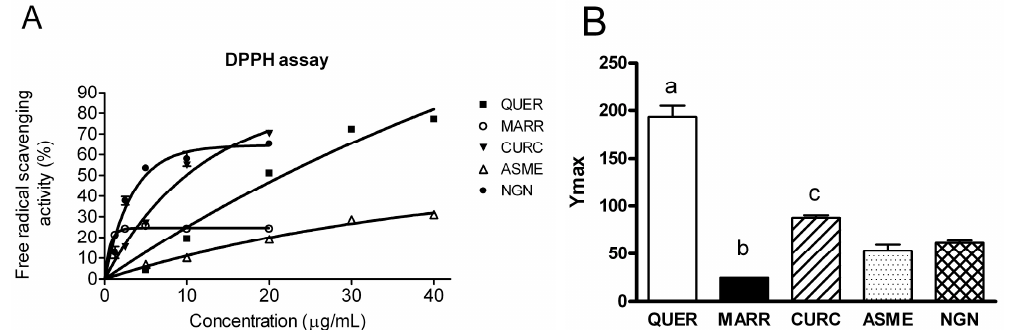
Figure 2. Antioxidant activity determination of quercetin (QUER), marrubiin (MARR), curcumin (CURC), ASME, and naringenin (NRG) by a α , α -diphenyl- β -picrylhydrazyl (DPPH). DPPH assay was performed as described in Materials and Methods. ( A ) Free radical scavenging activity of the compounds was determined as a function of increasing compound concentration. The curves were obtained by fitting the experimental points with computerized least-square regression (see Materials and Methods). The symbols represent means ± SEM of three different experiments. When not shown, SEM were within the symbol area; ( B ) Bars represent the Ymax constant values, obtained as described above. Values are means ± SEM of 3–6 different experiments. ( a ) p < 0.05 vs. MARR, CURC, ASME, NRG; ( b ) p < 0.05 vs. CURC, ASME, NRG; ( c ) p < 0.05 vs. ASME, NRG (ANOVA followed by